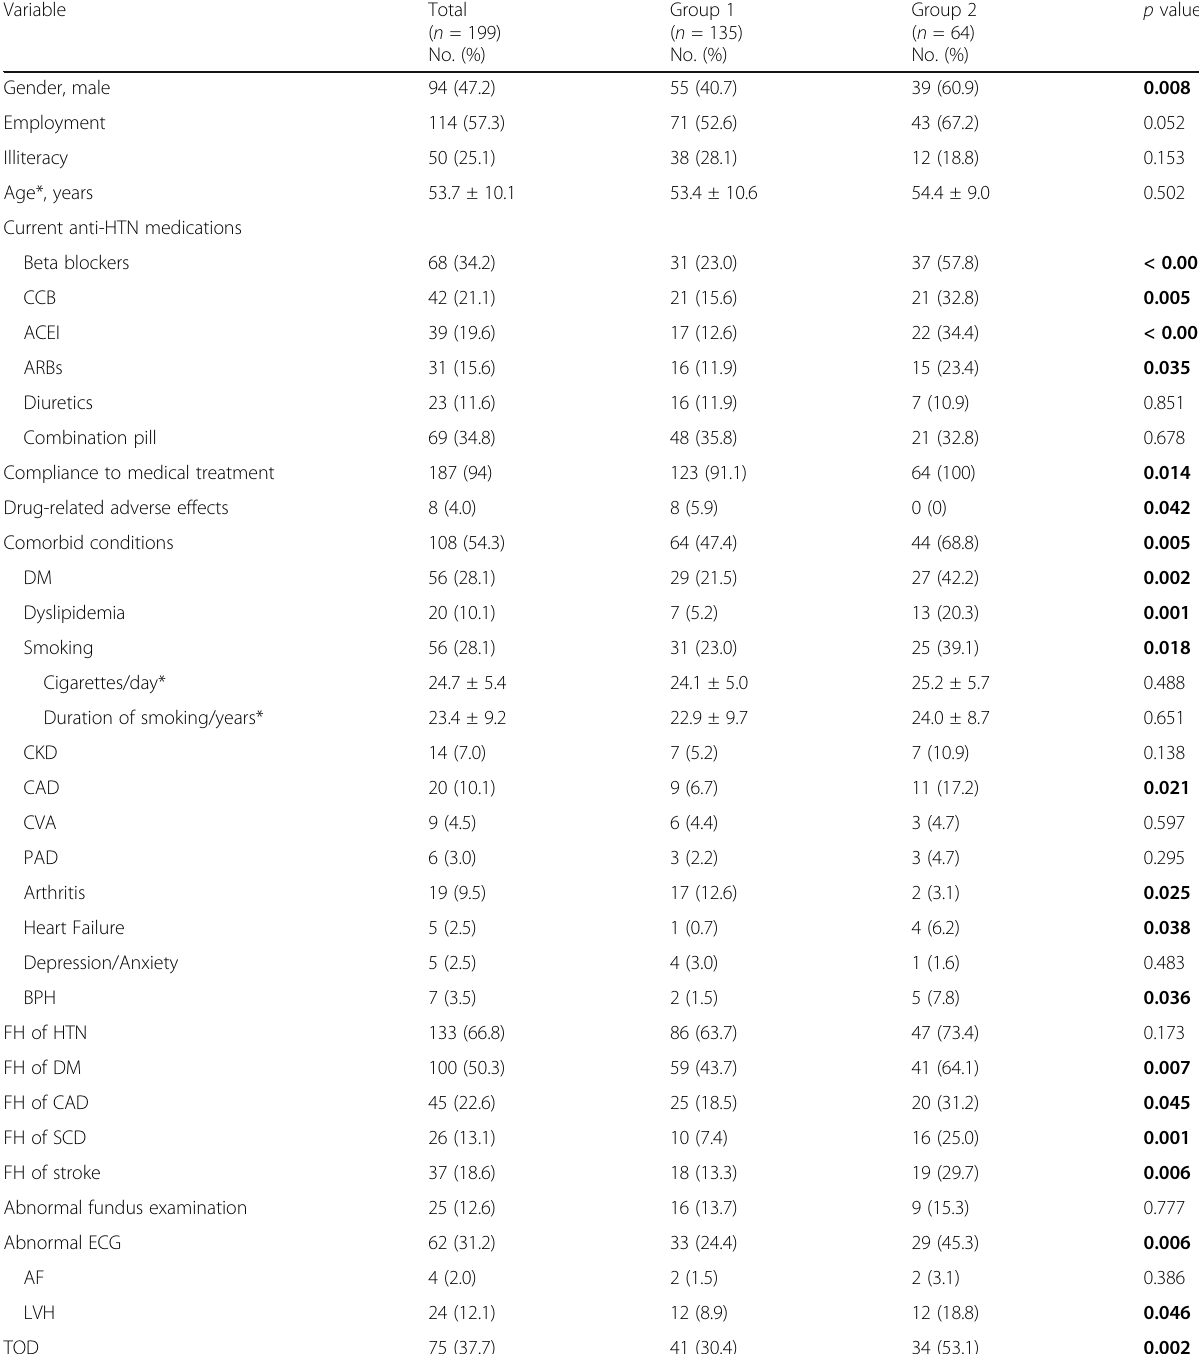
Table 1 The baseline clinical characteristics of the study population